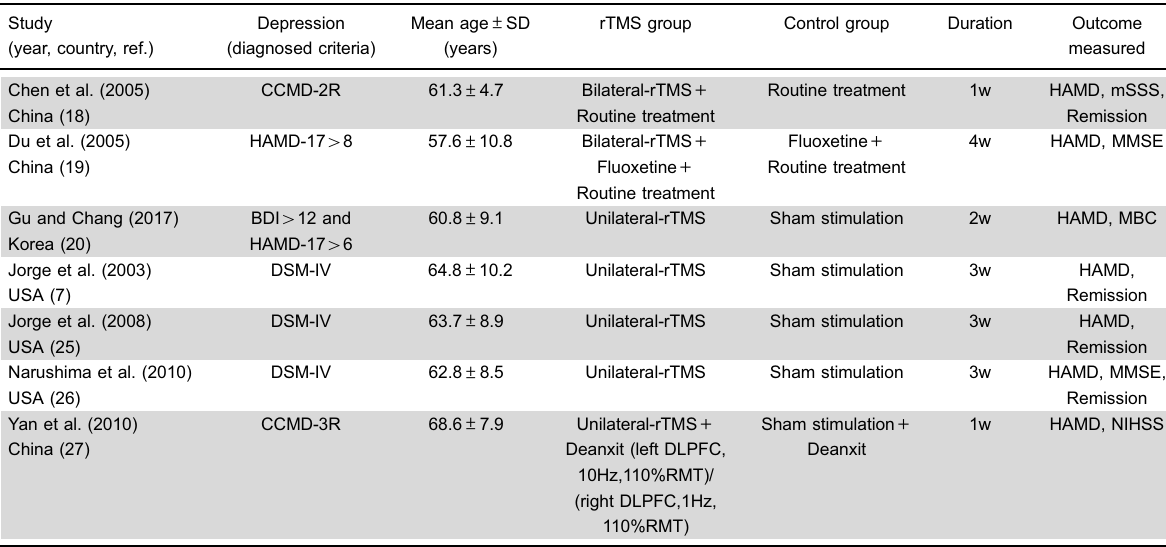
Table 1. Characteristics of randomized clinical trials included in the systematic review about comparison of repetitive transcranial magnetic stimulation (rTMS) and control conditions for post-stroke depression. Study (year, country, ref.)